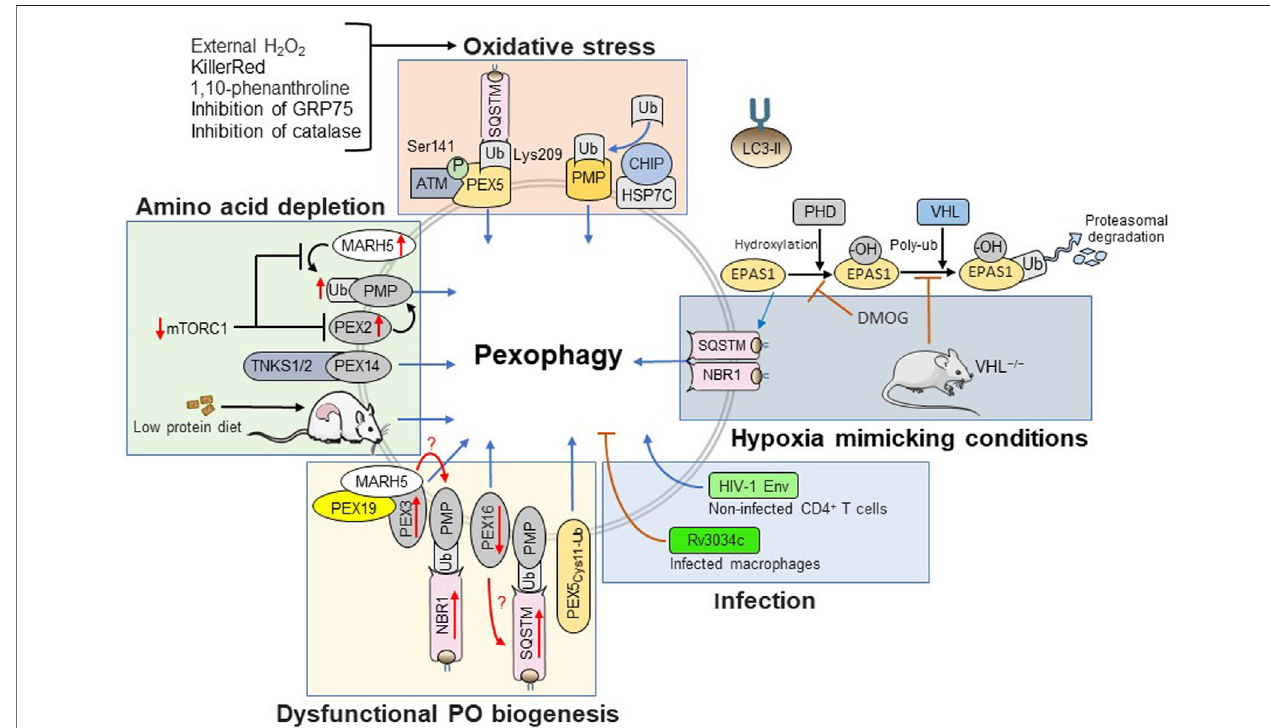
FIGURE 3 | Triggers and signaling pathways controlling